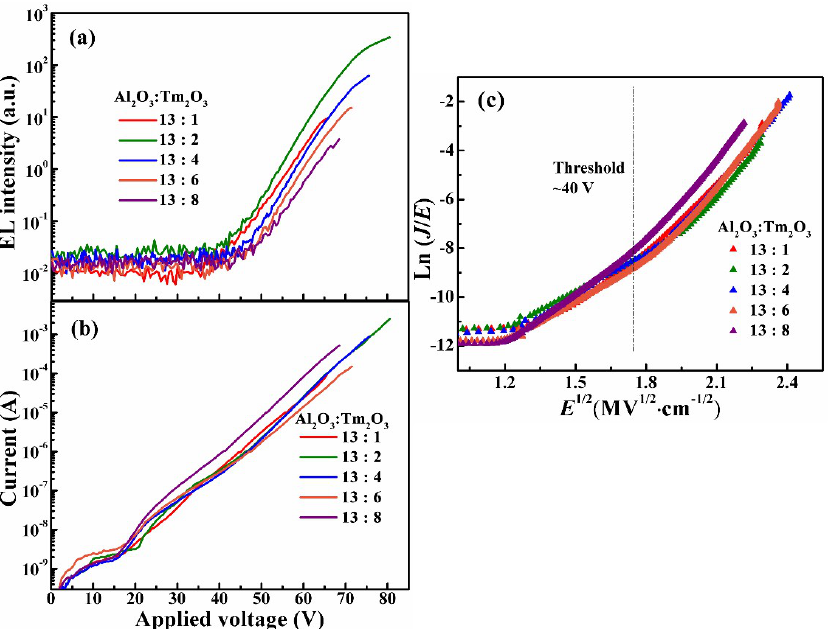
Figure 4. ( a , b ) The dependence of blue (456 nm) EL intensities, together with the injection current, on